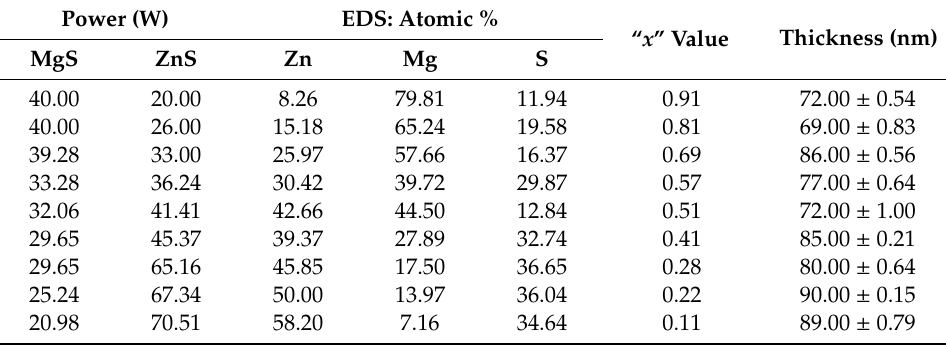
Table 2. Variation in elemental compositions.